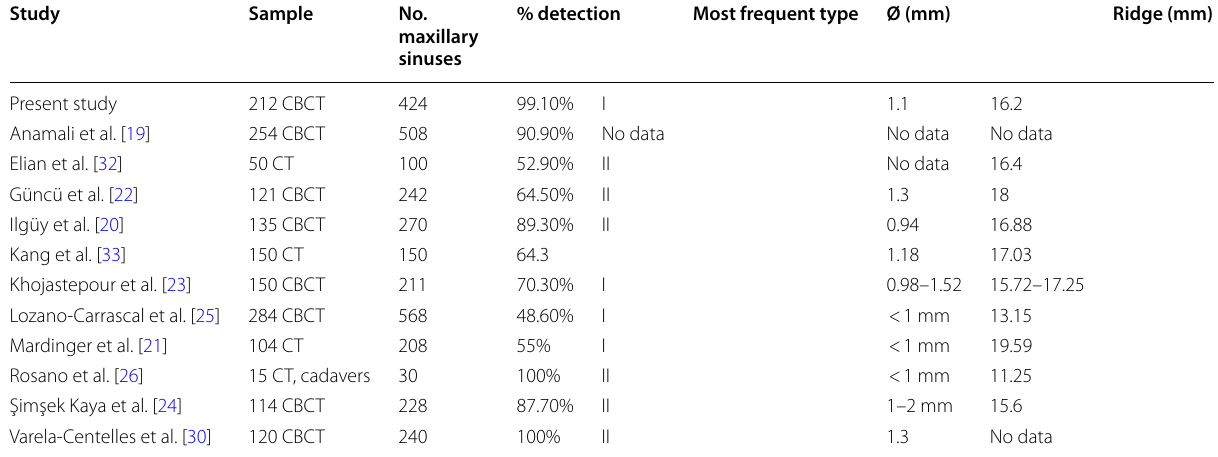
Table 4 Review of PSAA data from other studies